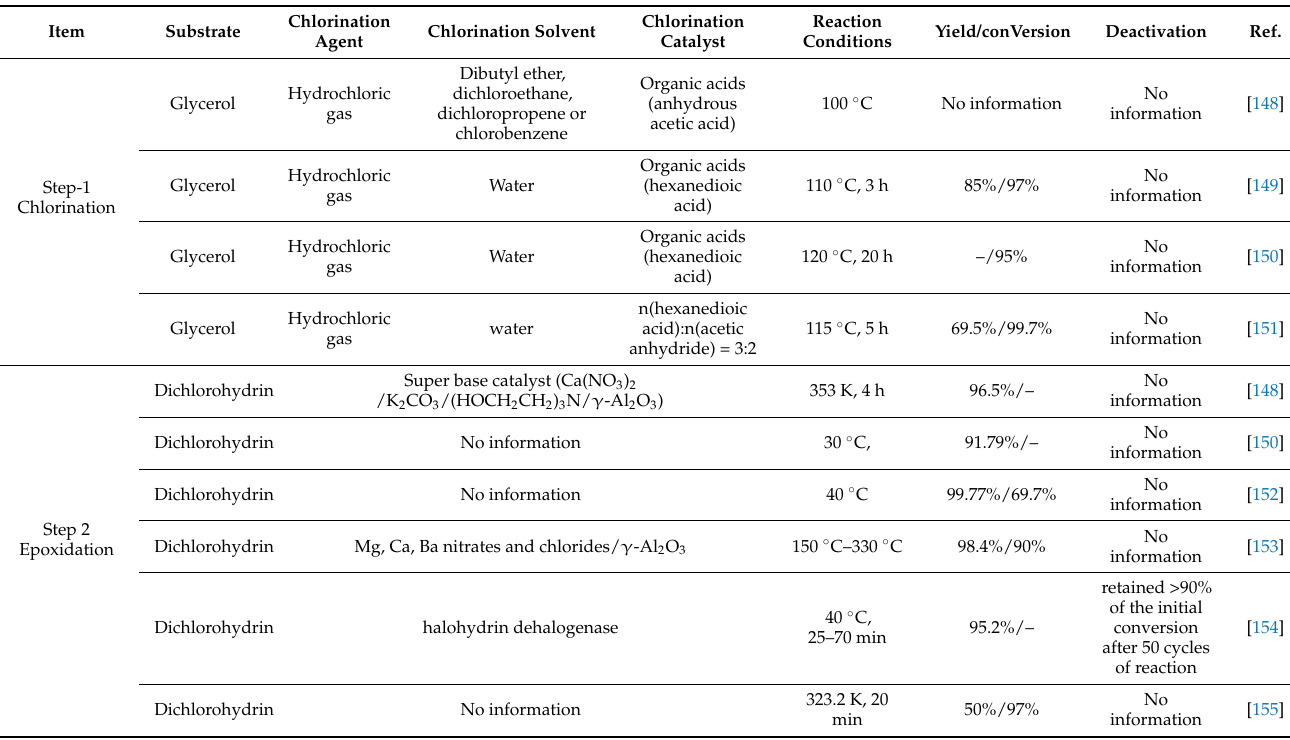
Table 5. Summary of catalyst systems for two-step synthesis of